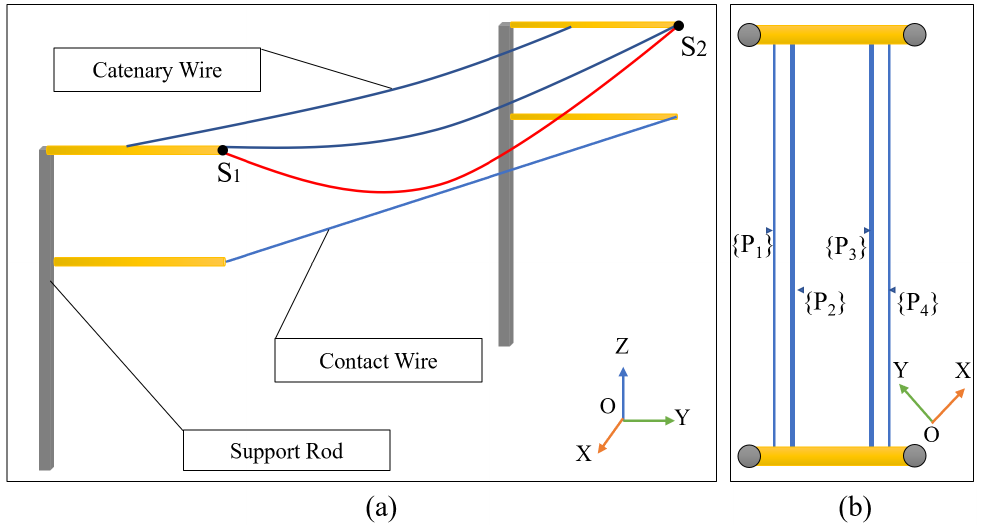
Figure 10. Schematic diagram of the structure of the railway overhead wires ( a ) side view; ( b ) top